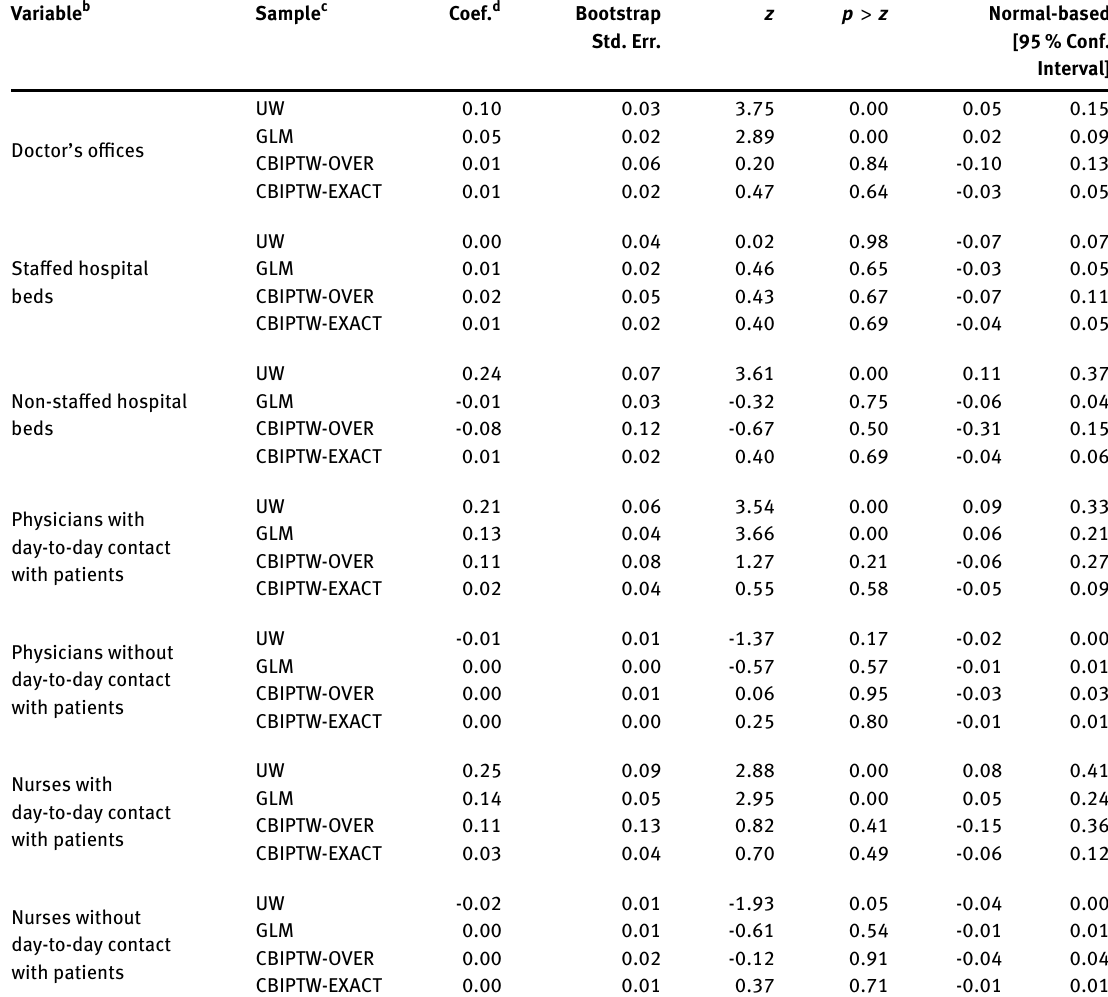
Table A.1: Covariate-Balance for Time-varying SP coverage on Sanitary Jurisdictions a